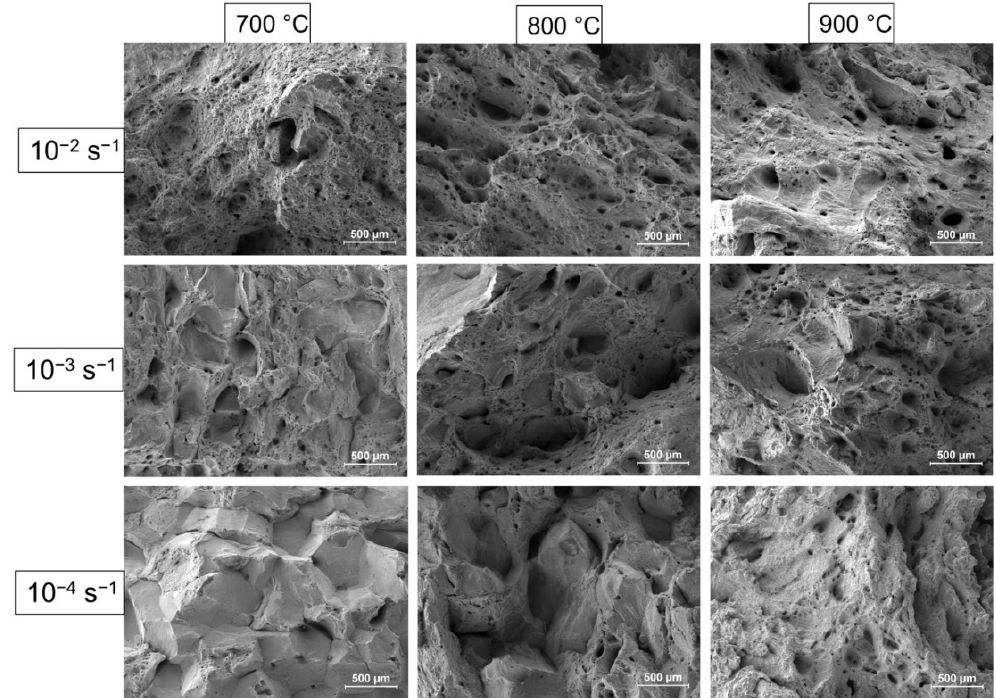
Figure 4. Fracture surfaces of steel B samples tested at different temperatures and strain rates.